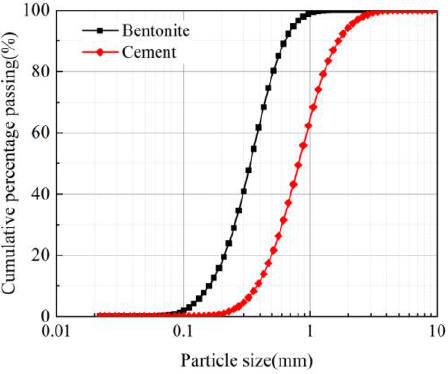
Figure 1. Gradation curve of bentonite and cement.